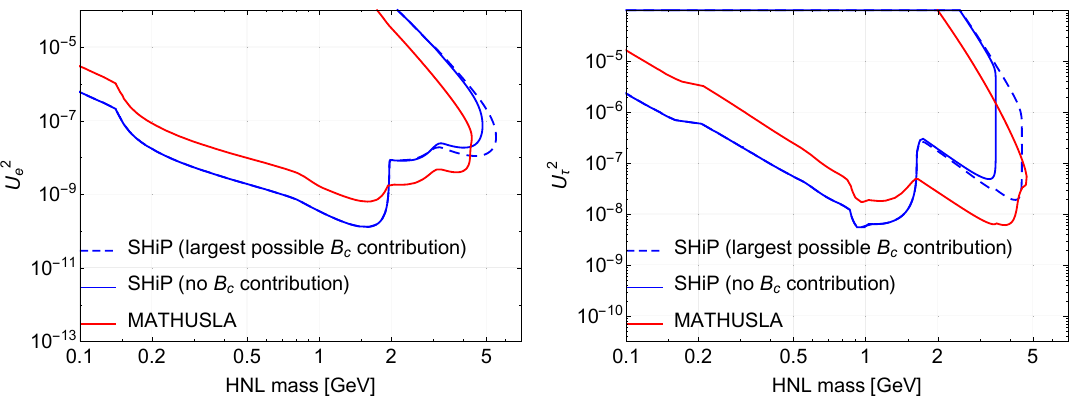
Figure 12 . Comparison of the sensitivity of SHiP and MATHUSLA for the HNL. The production mesons at SHiP energies √ s 28 GeV is not known, and the largest possible fraction of B c ≈ 3 . In contribution is based on the production fraction measured at the LHC, f ( b 10 B c ) = 2 . 6 − → × the case of the SHiP experiment we used the overall efficiency calibrated against the Monte Carlo simulations [31] and also selected only those channels where at least two charged tracks from the HNL decay appear. In the case of the MATHUSLA experiment we optimistically used (cid:26) = 1 for det the detection efficiency.